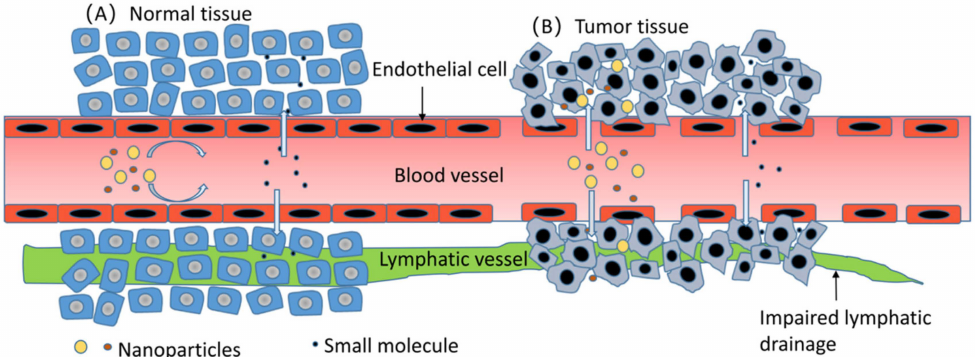
Figure 1. Compared with the tumor tissue in ( B ), the nutrient vascular epithelial cells in the normal tissue in ( A ) are arranged very closely, and only small molecules are easy to pass through; however, in ( B ), nanoparticles with a molecular diameter of 100–800 nm can smoothly pass through the nutrient vessels into the tumor tissue [4]. Moreover, there are few lymphoid tissues or only drainage-damaged lymphatic vessels in the tumor tissue, and the nanoparticles’ clearance will also be reduced